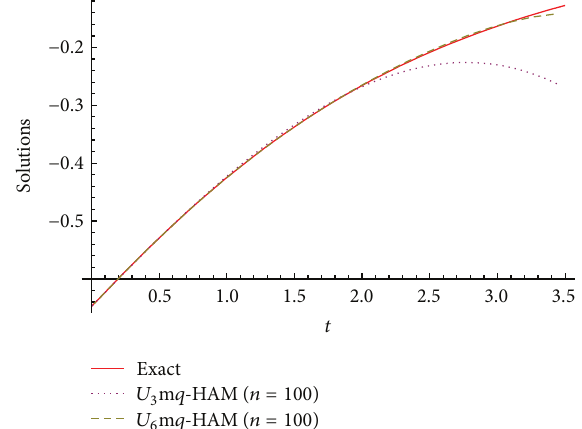
Figure 14: The comparison between the 𝑈 3 , 𝑈 6 of m 𝑞 -HAM (𝑛 = 100) , and the exact solution of (40) at ℎ = −79.5 and 𝑥 = 1 .